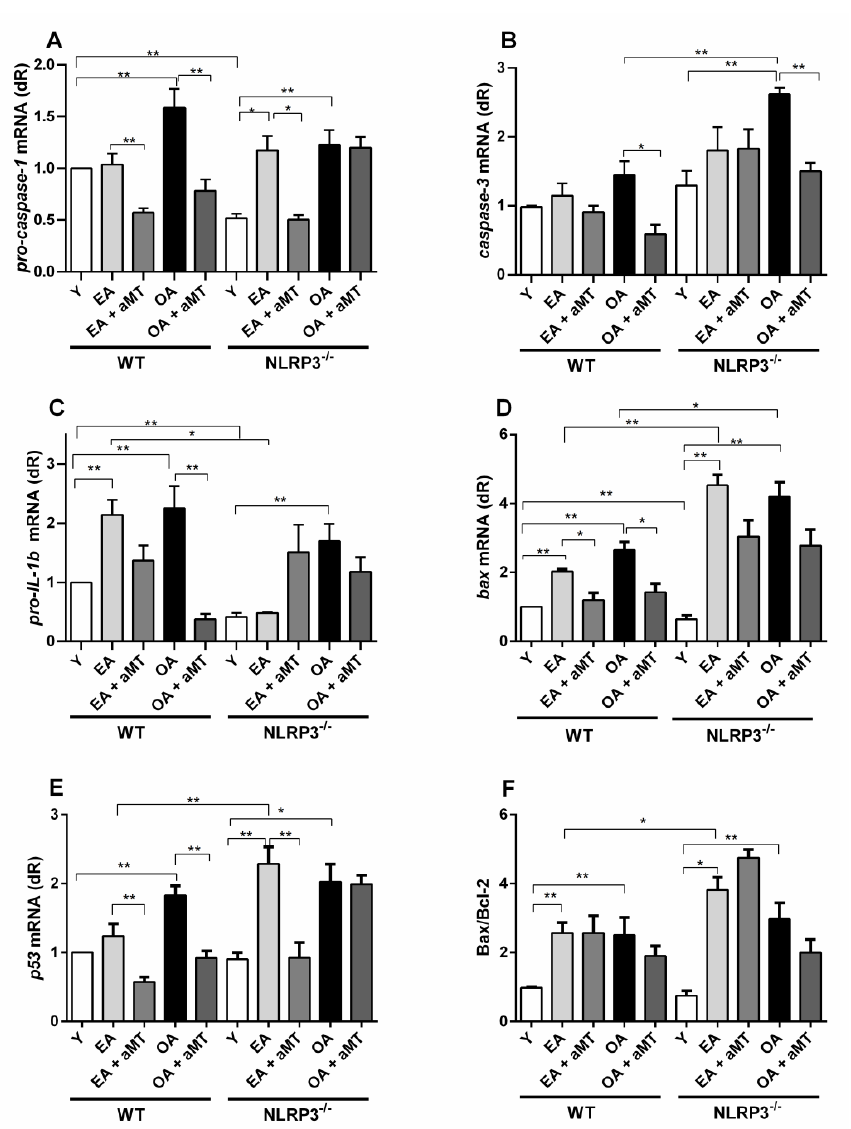
Figure 2. Changes in mRNA expression of the molecular inflammatory and apoptosis parameters in WT and NLRP3 − during aging and melatonin supplementation. Experiments were performed in gastrocnemius muscle of young (Y), early aged (EA), early aged with melatonin (EA + aMT), old-aged (OA), and old-aged with melatonin (OA + aMT) of wild type (WT) and NLRP3 − mice. Following mRNA expression levels were measured by qRT-PCR analysis: A -pro-caspase-1, B -caspase-3, C -pro-IL-1 β , D -Bax, E -p53, and F -ratio Bax/Bcl-2. Increased pro-caspase-1, pro-IL-1 , bax , p53 levels and Bax/Bcl-2 ratio with age in WT animals, were contrarested by melatonin ad- ministration in all parameters, except Bax/Bcl-2 ( A , C – E ). Aging afected the expression of all mo- lecular parameters in NLRP3 - animals ( A – F ), although the levels of pro-caspase-1, pro-IL- 1β and bax were lower in early aged mutant animals compared to the WT ones of the same age ( A , C , D ). Melatonin administration decreased pro-caspase-1 and p53 expression in EA NLRP3- group ( A , E ), as well as reduced caspase-3 levels in OA mutant mice ( B ). Data are expressed as means ± SEM (n = 5 animals/group). Comparisons between groups are indicated in the graphs. * p < 0.05 and ** p < 0.01.